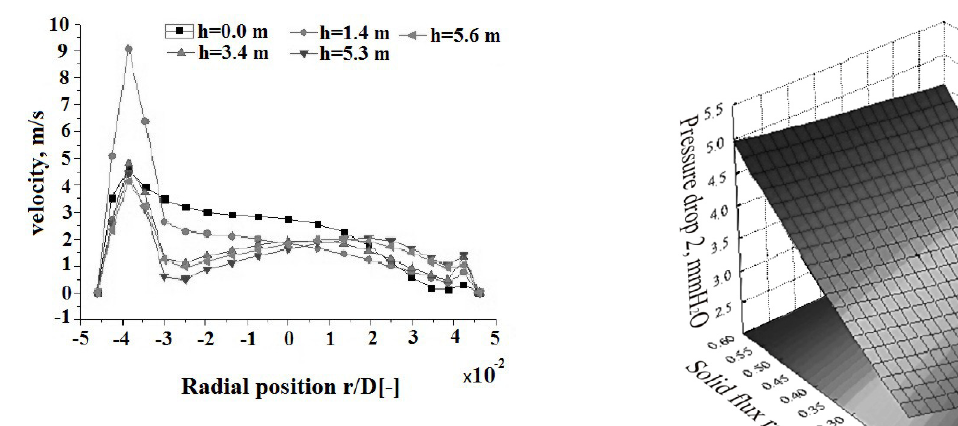
Fig. 8. Radial profiles of solid velocit`a at different heights of riser.